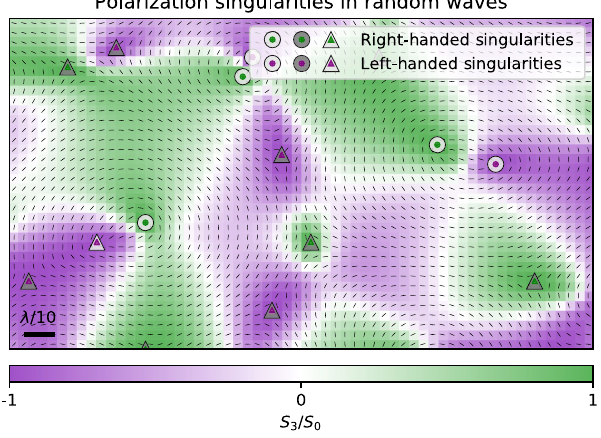
FIG. 5. False-color map for the degree of circular polarization s 3 ¼ S 3 =S 0 , as obtained from our experimental data. The plot corresponds to the same subsection of the measured optical random field displayed in Fig. 2. The black directors indicate the orientation of the polarization ellipse. Circles and triangles are C points, and their color (purple or green) represents their handedness (left or right,